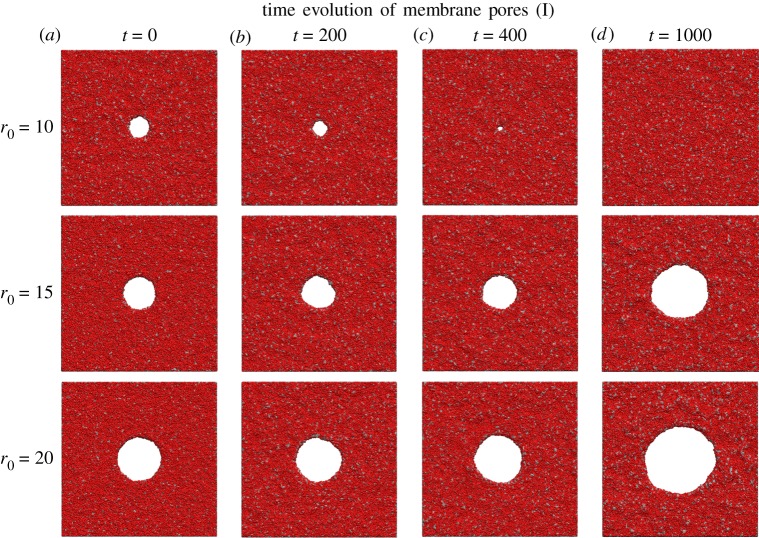
Rendered images of pores of three different initial sizes (rows). Four images throughout the simulation are shown, progressing from (a–d). Pores shrink or grow exponentially depending on the initial pore radius.